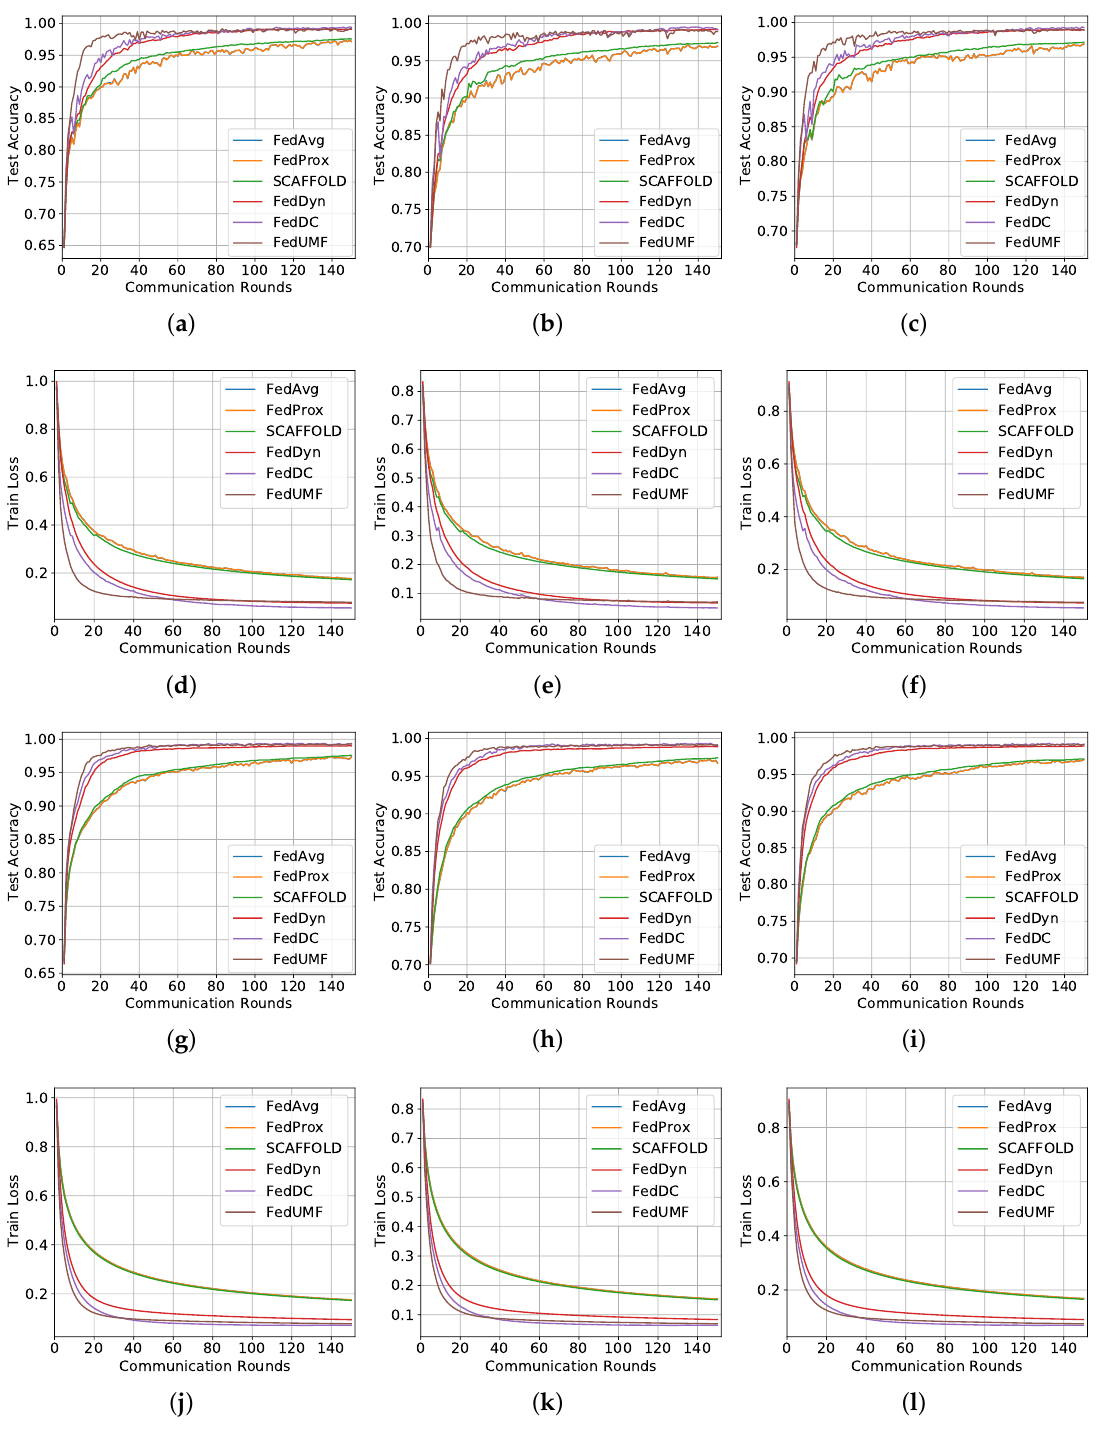
Figure A5. Convergence and loss plots on the synthetic dataset. There are three types of settings: the homogeneous setting with (0, 0), and two heterogeneous settings with (1, 0) and (0, 1), respectively. ( a ) Synthetic (0, 0) 15% Test Acc. ( b ) Synthetic (0, 1) 15% Test Acc. ( c ) Synthetic (1, 0) 15% Test Acc. ( d ) Synthetic (0, 0) 15% Train Loss. ( e ) Synthetic (0, 1) 15% Train Loss. ( f ) Synthetic (1, 0) 15% Train Loss. ( g ) Synthetic (0, 0) 65% Test Acc. ( h ) Synthetic (0, 1) 65% Test Acc. ( i ) Synthetic (1, 0) 65% Test Acc. ( j ) Synthetic (0, 0) 65% Train Loss. ( k ) Synthetic (0, 1) 65% Train Loss. ( l ) Synthetic (1, 0) 65% Train